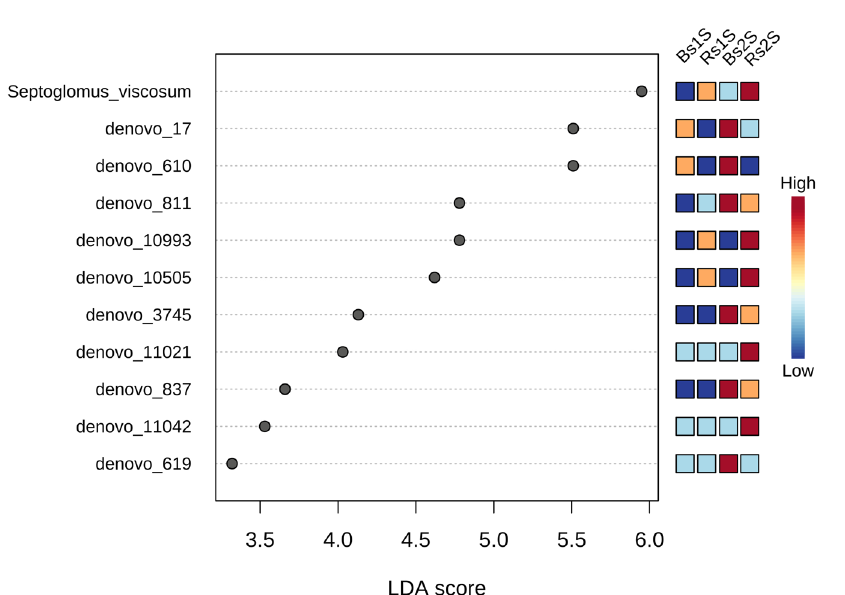
Figure 8. Linear discriminant analysis Effect Size (LEfSe). LEfSe results using non-parametric factorial Kruskal-Wallis (KW) sum-rank test. Adjusted p-value cutoff = 0.05 and LDA score = 1.0; de novo_ 17 = Uncultured Archeospora (LDA score 5.51); de novo_ 610 = Uncultured Rhizophagus (LDA score 5.51); de novo_ 811 = Uncultured Rhizophagus (LDA score 4.78); de novo_ 10993 = Uncultured Glomus (LDA score 4.78); de novo_ 10505 = Septoglomus viscosum (LDA score 4.62); de novo_ 3745 = Uncultured Archeospora (LDA score 4.13); de novo_ 11021 = Uncultured Glomus (LDA score 4.03); de novo_ 837 = Uncultured Glomus (LDA score 3.66); de novo_ 11042 = Uncultured Glomus (LDA score 3.53), de novo_ 619 = Uncultured Glomus (LDA score 3.32). LEfSe analysis was performed with MicrobiomeAnalyst, a free available on-line software (https://www.